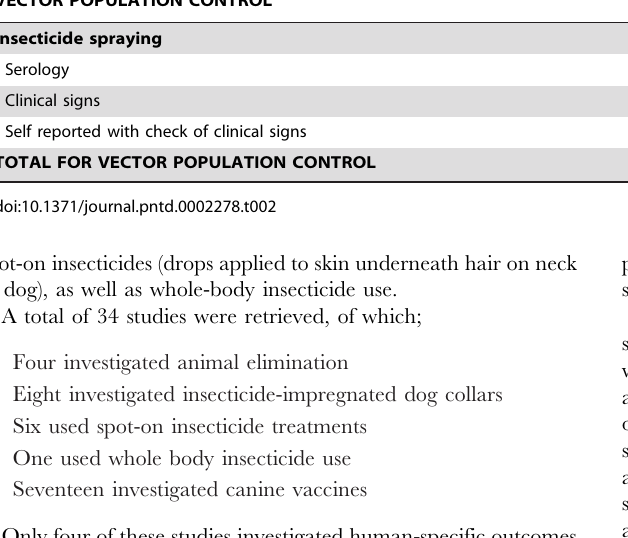
VECTOR POPULATION CONTROL